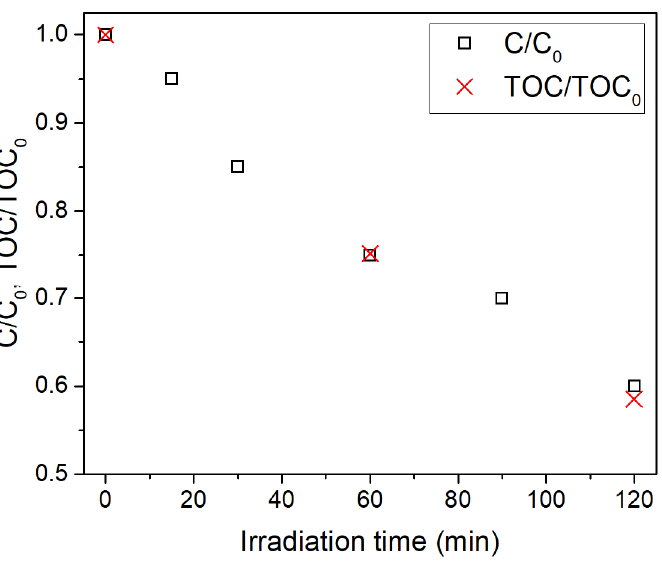
Figure 5. Comparison of photocatalytic degradation of formic acid over TiO 2 -P25 monitored by UV-vis spectra (C/C 0 ) and total organic carbon measurements (TOC/TOC 0 ).